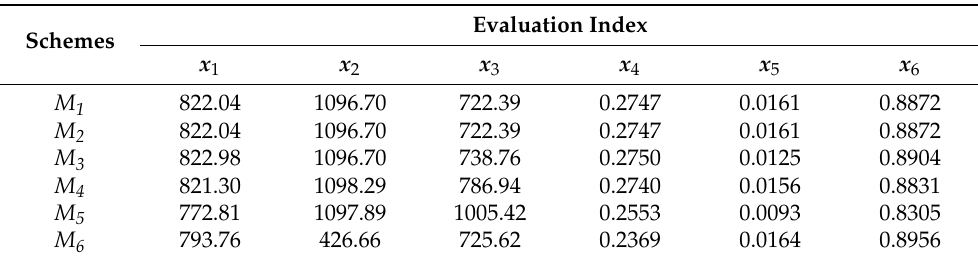
Figure 1. The water system diagram of the Ertan Hydropower Project area. Table 3. Optimal operation results of Ertan Reservoir under all kinds of control schemes of the release